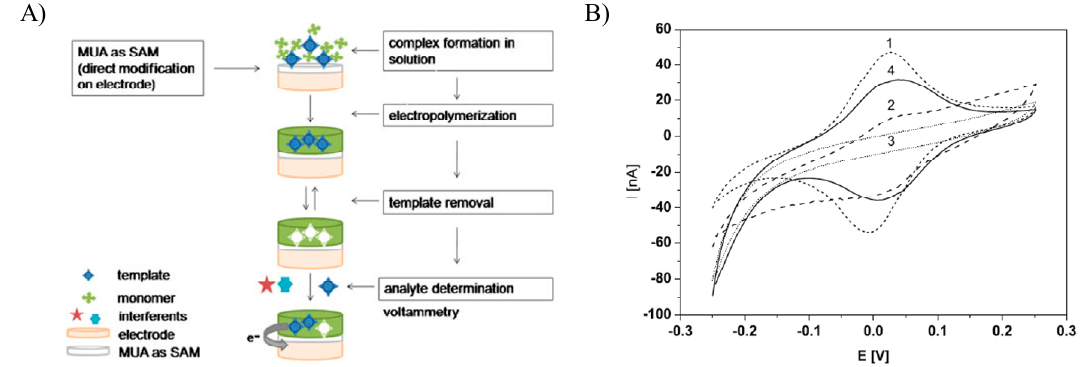
Figure 4. ( A ) Workflow of the preparation of the cytochrome c MIP and ( B ) the electrochemical readout indicating the DET at the MUA-covered Au electrode (1), after electropolymerization (2), after template removal (3) and rebinding (4). Reprinted by permission from [46].